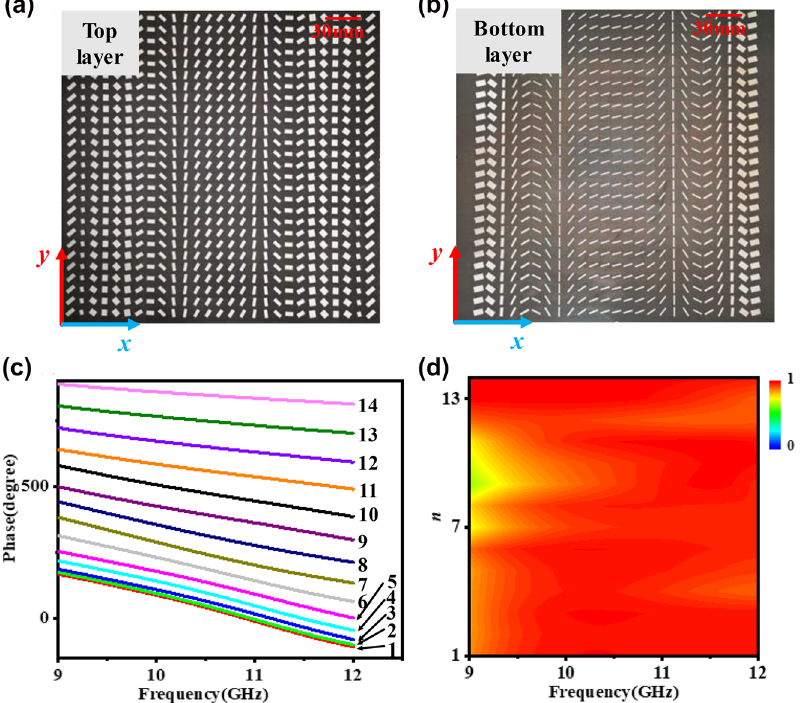
Figure 4: Design of the achromatic meta-lens. (a) Top layer and (b) bottom layer of the fabricated sample of achromatic meta-lens. (c) The phase profile and (d) amplitude spectrum of the achromatic